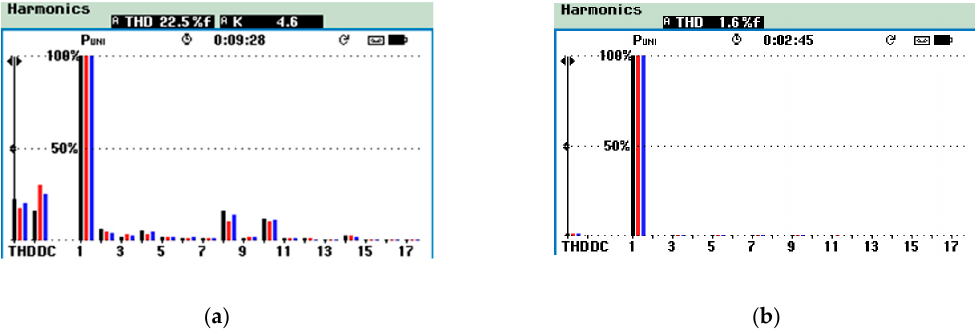
Figure 23. Current spectrum in the grid without the micro-grid. ( a ) Load side current spectrum. ( b ) PCC side current compensated spectrum.